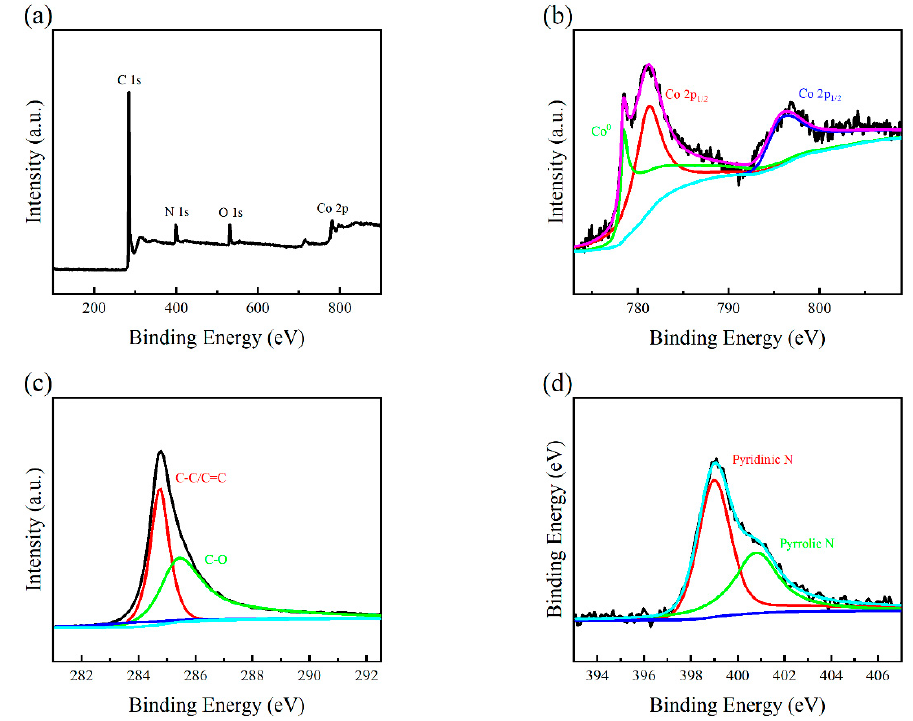
Figure 5. The Raman spectra of CNCG-2. ( a ) The XPS spectrum of CNCG-2; ( b ) The Co 2p spectrum of CNCG-2; ( c ) The C 1s spectrum of CNCG-2; ( d ) The N 1s spectrum of CNCG-2.